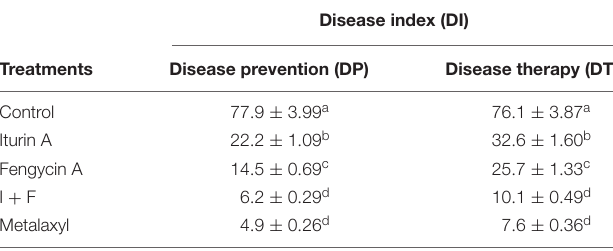
TABLE 3 | Biocontrol effect of Iturin A and Fengycin A on potato leaflets in vitro